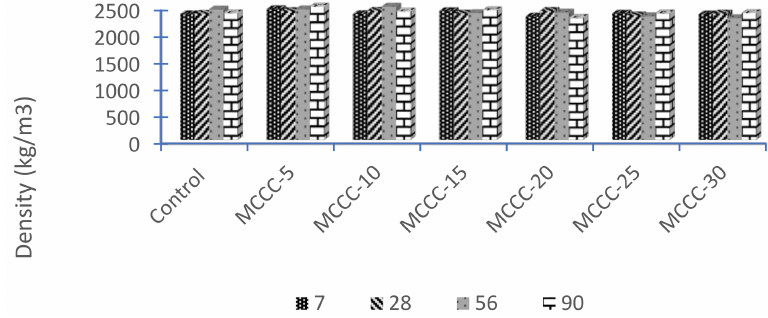
Figure 9. Density of HPC made with different contents of